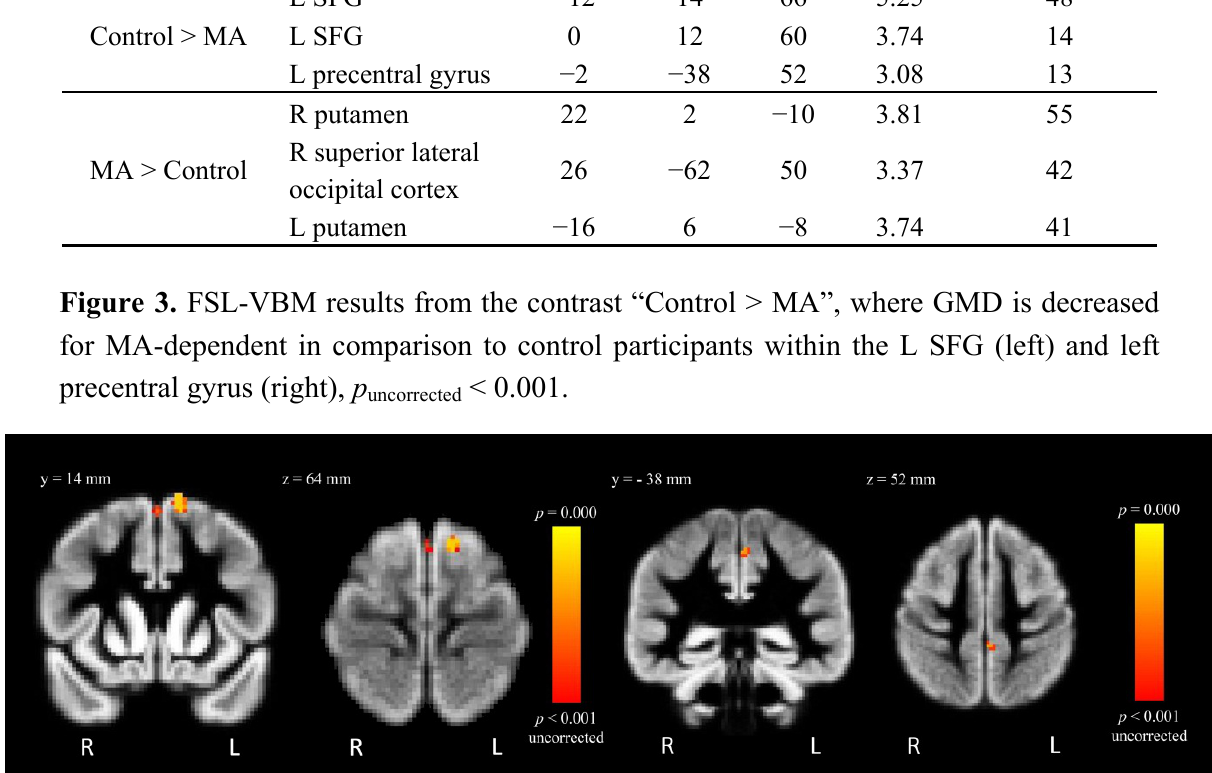
< 0.001) for voxel-wise regressions from uncorrected